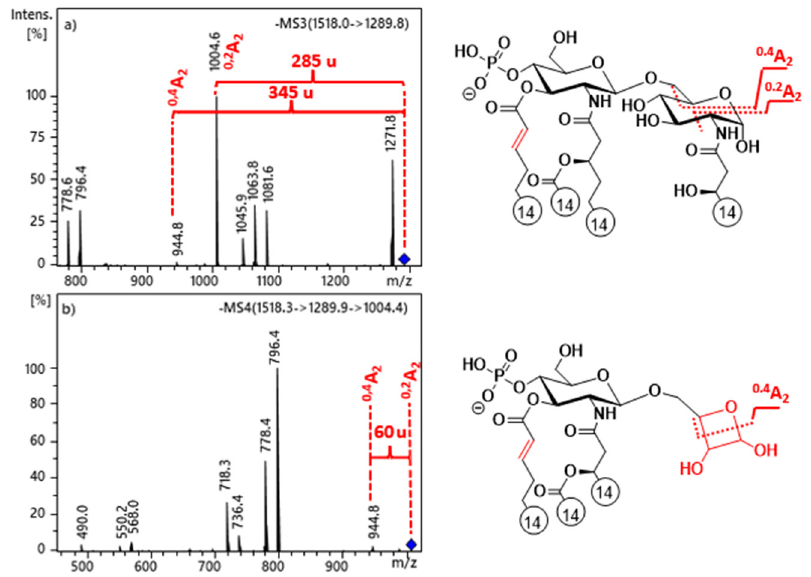
Figure 2. ESI-ion trap mass spectra obtained at MS 3 and MS 4 stages of selected ions at ( a ) m / z 1290 and ( b ) m / z 1005 for 3D-PHAD, demonstrating the structural relationship between 0,2 A 2 and 0,4 A 2 cross-ring fragment ions in 3-deacyl lipid A.